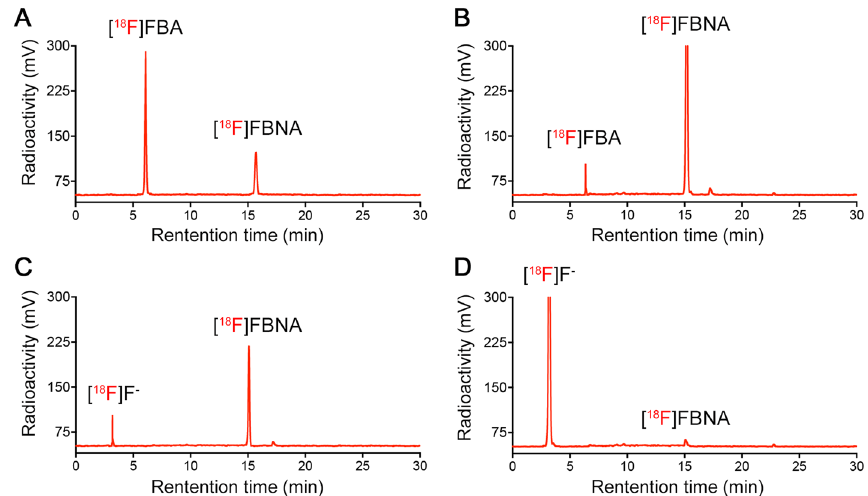
Fig. 3 Radio-HPLC traces of the reaction ([ 18 F]FBNA: t R . 65 °C ( B ), 85 °C ( C ) and 100 °C ( D )